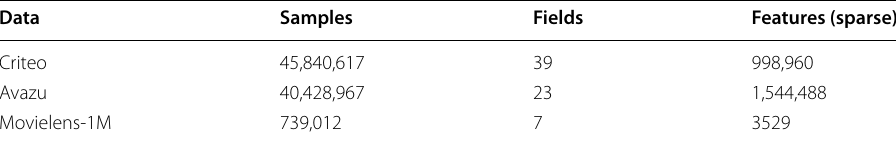
Table 1 Statistics of evaluation data sets